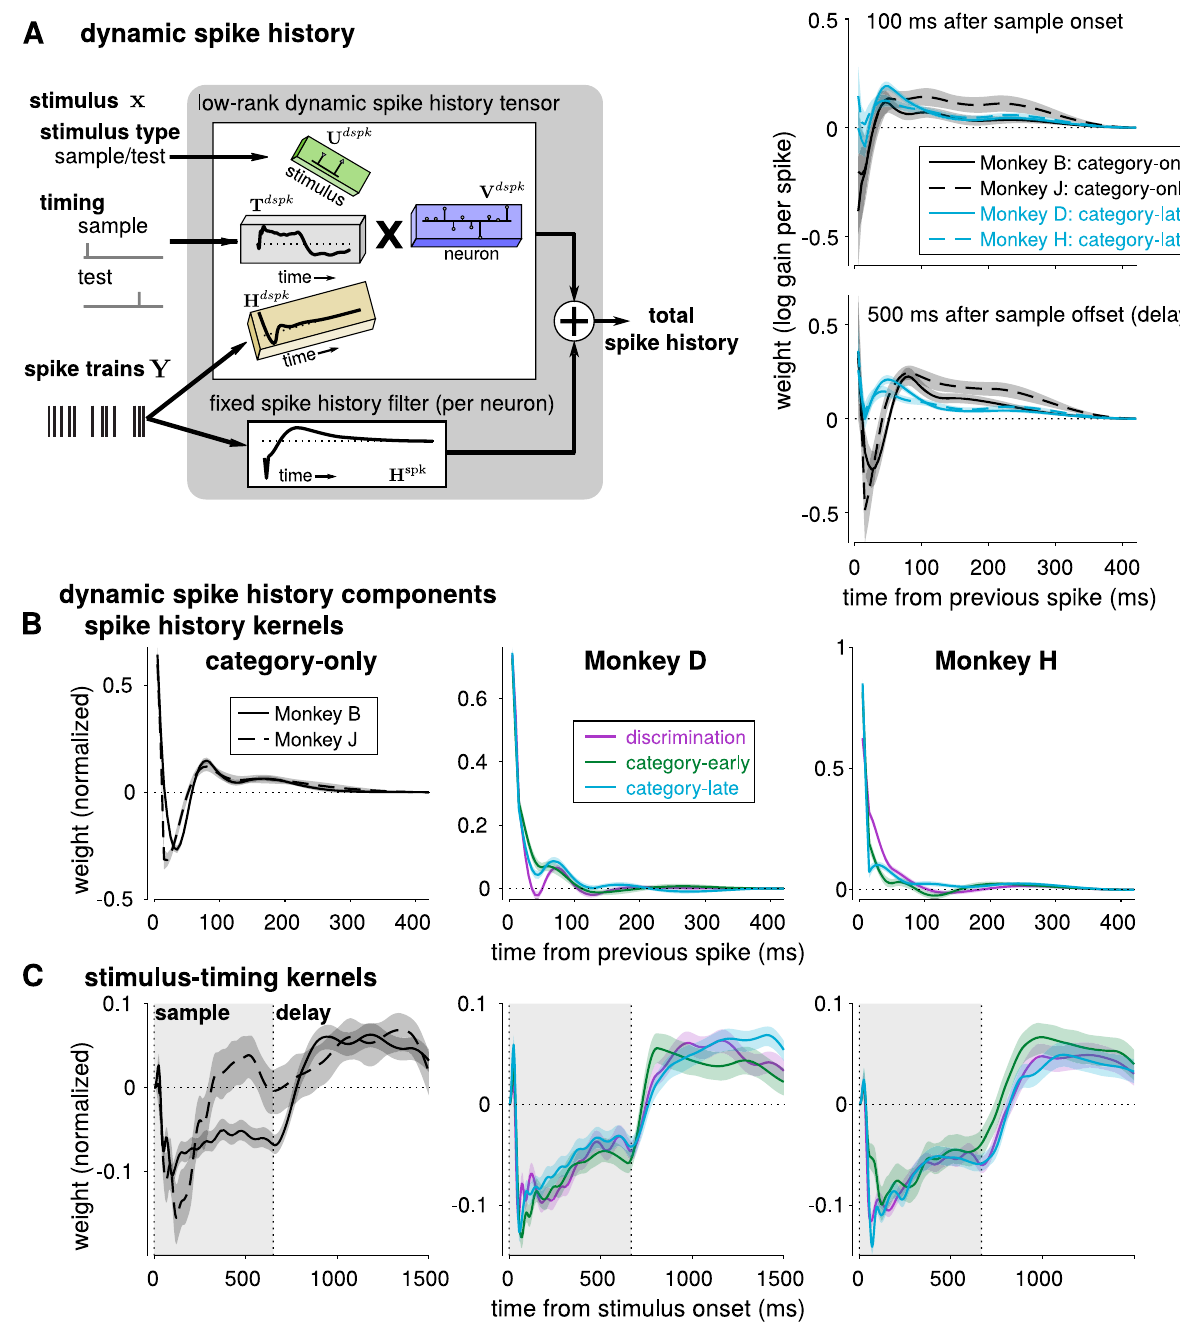
Fig. 10 | Dynamic spike history captures distinct stimulus-driven and delay- perioddynamics.A Thedynamicspikehistory fi lterisalow-rank,four-waytensor. Thetensorincludestwotemporalkernels:onewhich fi ltersspikehistory(gold)and a second which determines the weighting of the spike history component relative to the stimuli(gray).The spike historyisscaled bystimulus identity (forsimplicity, limitedtosampleorteststimulusweightsonly,withoutanycategoryinformation). Eachneuron addsthe (weighted) dynamically fi ltered spike historyto theneuron ’ s constant spike history fi lter. The total spike history at any point in a trial is still a linear function of past spiking activity, but the effective linear kernel can change duringatrial.Thenormalizedrank-1dynamicspikehistorycomponents: B dynamic spike history kernels and C stimulus-timing kernels for each population (posterior